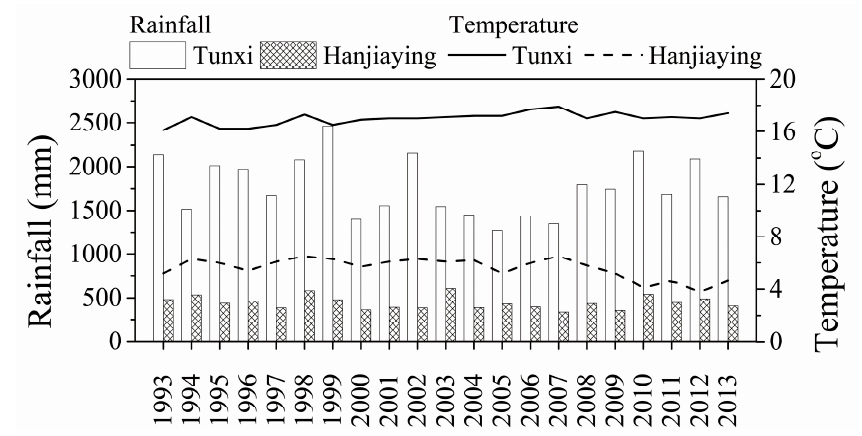
Figure 2. Mean annual rainfall and temperature of two sites between 1993 and 2013.